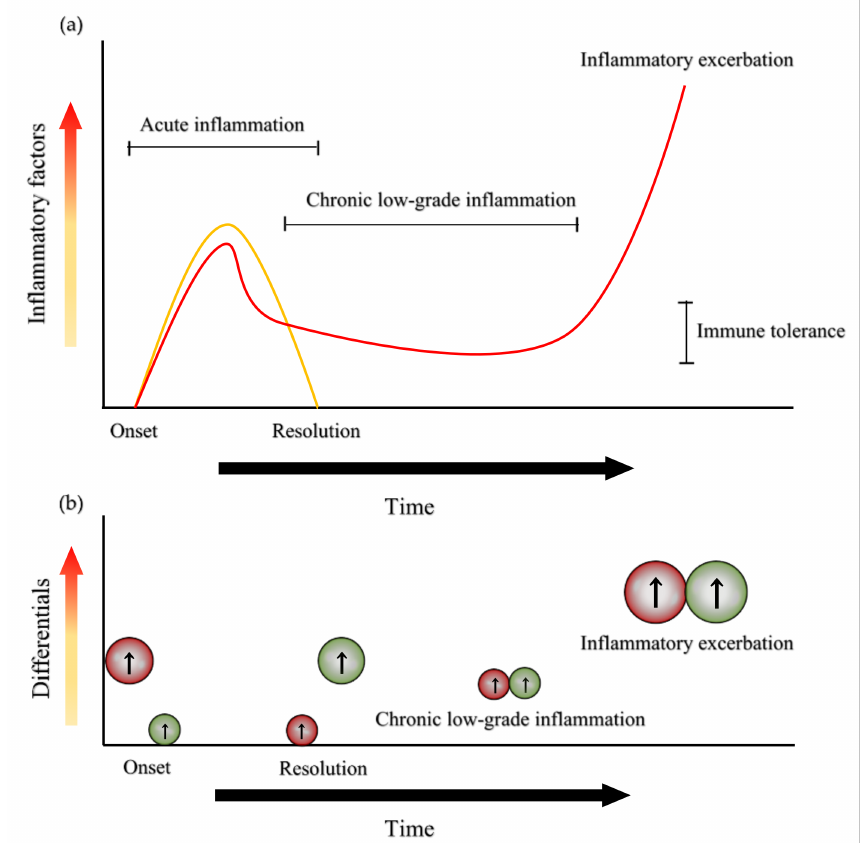
Figure 1. Acute inflammation, chronic low-grade inflammation and the status of pro-inflammatory and anti-inflammatory factors. ( a ) Acute inflammation onsets with the increase of inflammatory factors and is resolved with the decrease of inflammatory cytokines (yellow line). Chronic low- grade inflammation (LGI) is characterized by a period of relatively low-level inflammatory factors that induce immune tolerance. Eventually, inflammatory factors increase, leading to inflammatory exacerbation and contributing to the pathogenesis of various diseases (red line). ( b ) Relative levels of pro-inflammatory (in red) and anti-inflammatory (in green) factors after the onset and before the resolution of acute inflammation, during LGI and at inflammatory